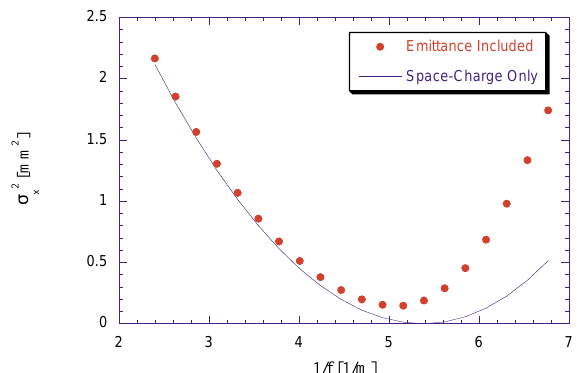
FIG. 11. (Color) Simulations of a quad scan with and without emittance. The solid line represents a simulation without the emittance forces, while the data points show a simulation of the full envelope